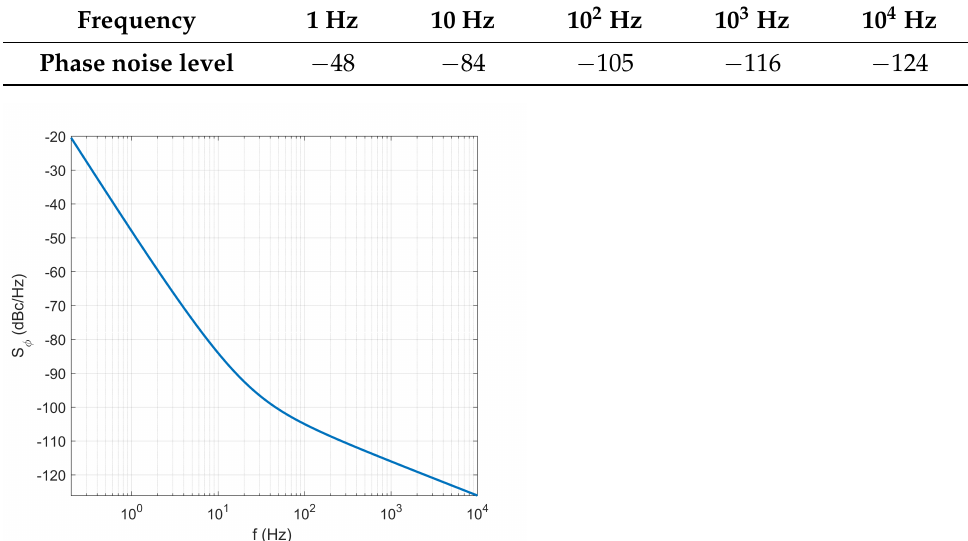
Figure 9. Power spectral density S φ ( f ) of oscillator phase